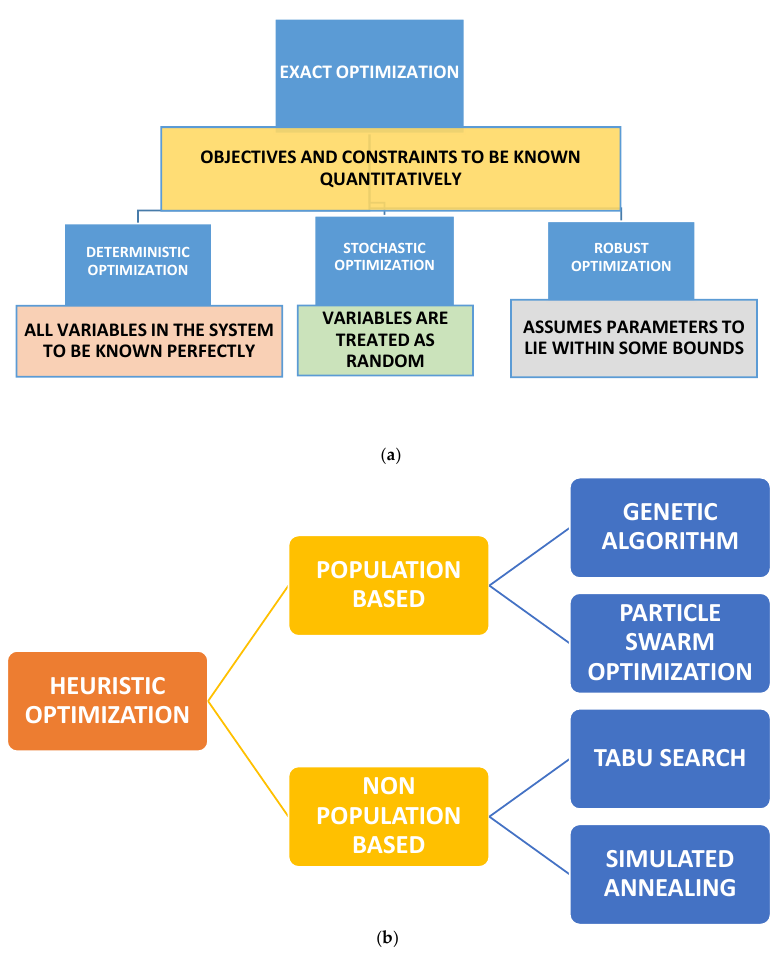
Figure 16. ( a ) Classification of exact optimization depending on treatment of uncertainties. ( b )Classification of Heuristic optimization.